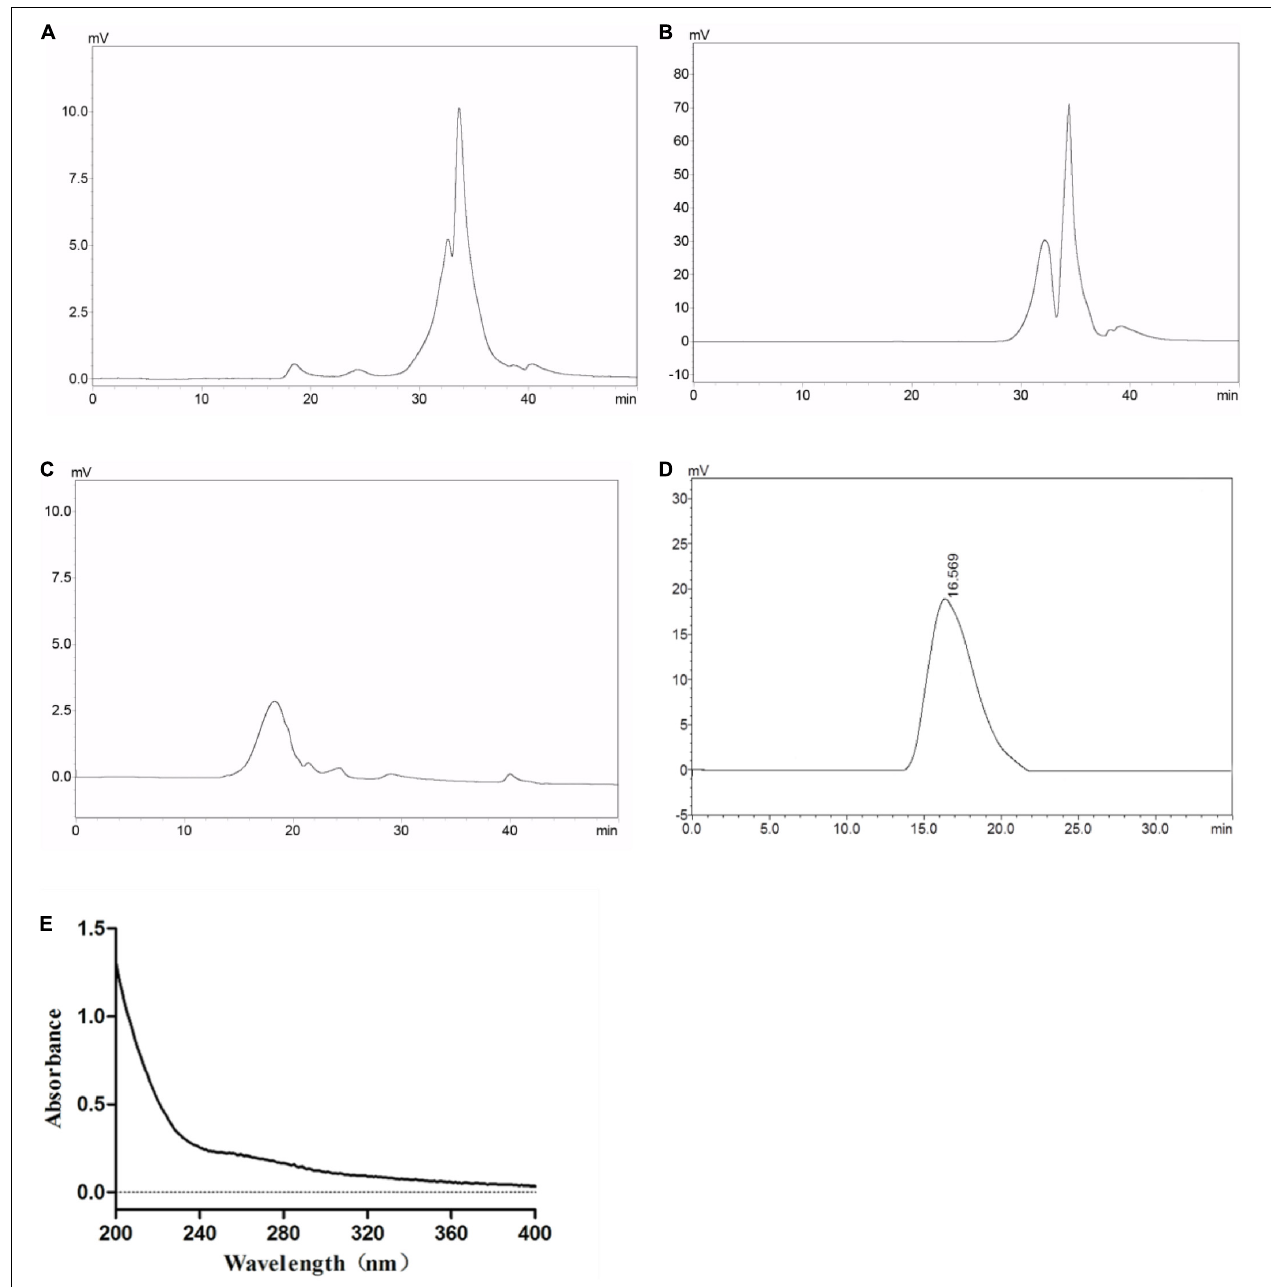
FIGURE 1 | Average molecular weight distribution of (A) GLP, (B) EGLP, (C) RGLP, (D) RGLP-1 and ultraviolet absorption spectrum (E) of RGLP-1.